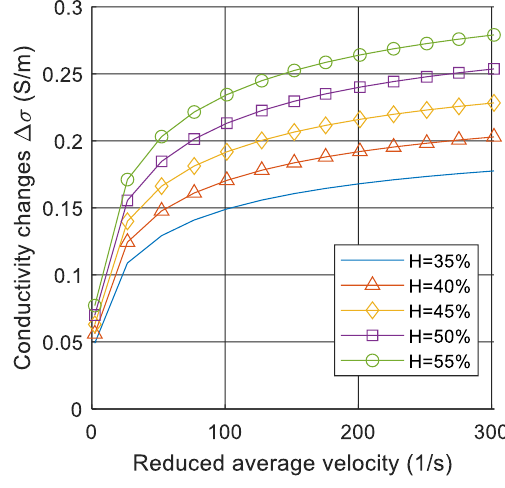
Fig.5: The blood conductivity changes as a function of reduced average velocity 〈𝑣/𝑅〉 for different haematocrit ( 𝐻 )